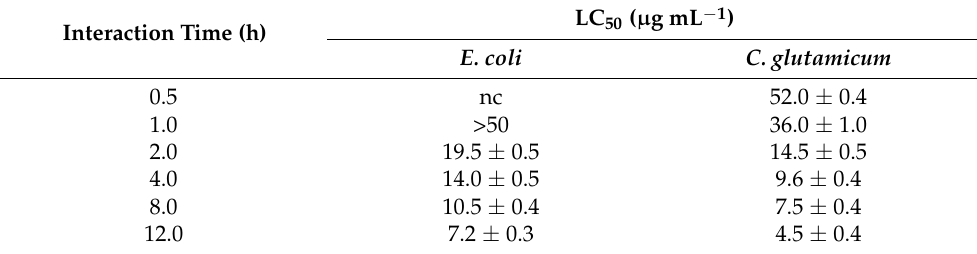
Table 3. LC 50 of AgNPs against E. coli and C. glutamicum at various interaction times. Interaction Time (h)